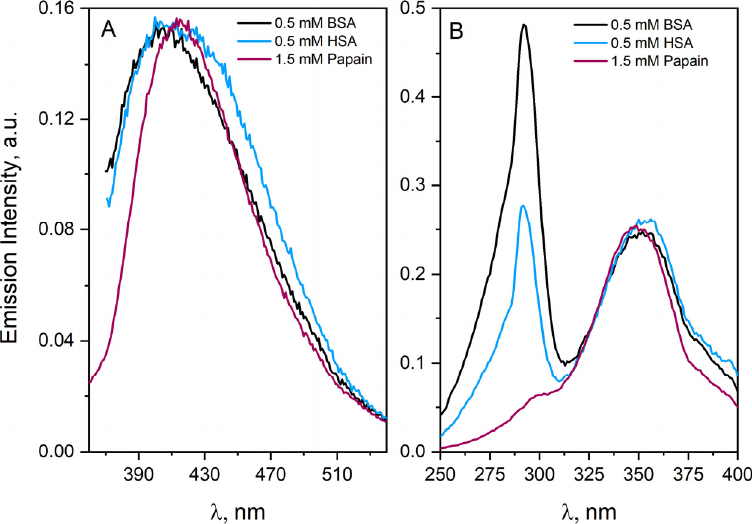
Figure 3. ( A ) Emission spectra of the neat HSA (0.5 mM), BSA (0.5 mM) and papain (1.5 mM) solutions. The excitation wavelength was 320 nm. Spectra were normalized. ( B ) Emission excitation spectra of the neat HSA (0.5 mM), BSA (0.5 mM) and papain (1.5 mM) solutions. The emission wavelength was 430 nm. Spectra were normalized.